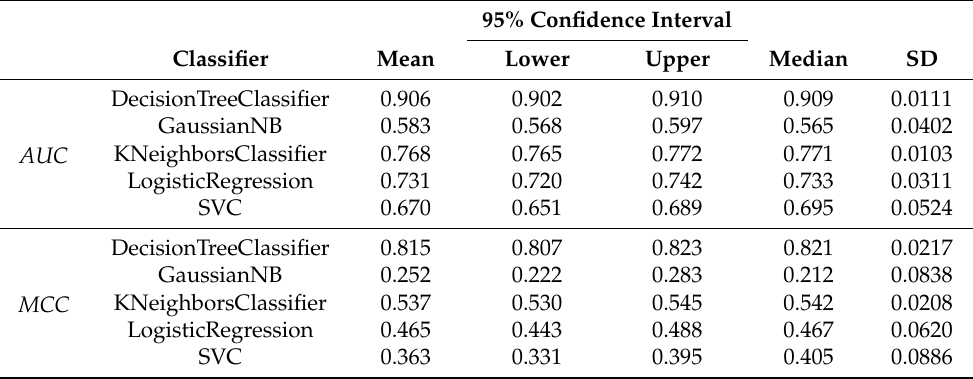
Table 3. The mean, median, standard deviation (SD) and 95% confidence interval of the AUC and MCC metric test set results of the experiments with the five tested machine learning